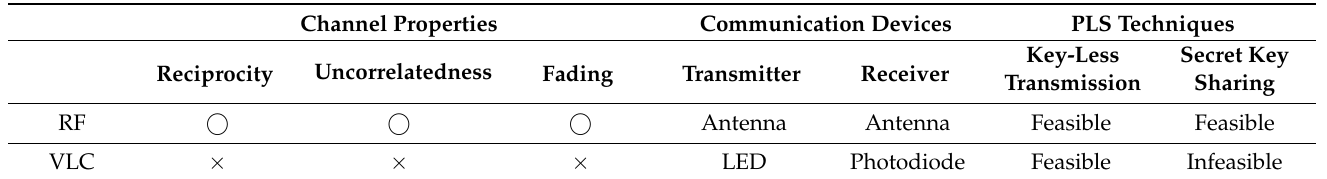
Table 1. Differences in security environments between radio frequency (RF) and visible light commu- nication (VLC)